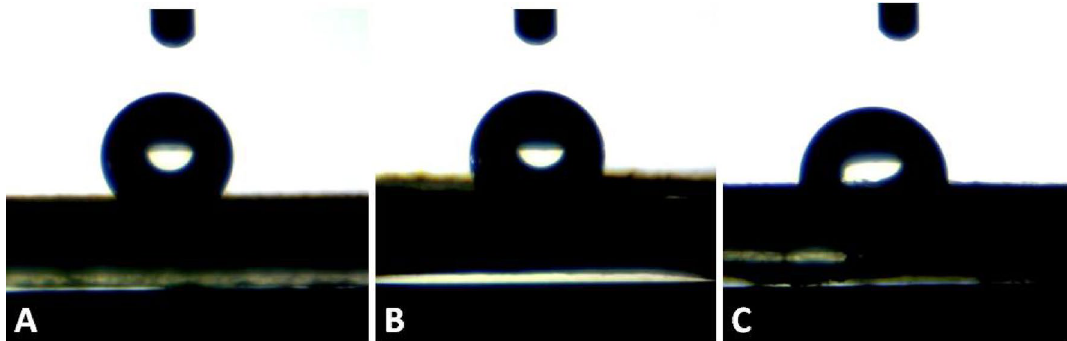
Figure 2. The surface contact angle of different PCL solutions in the 20th second ( P -value < 0.0005). ( A ) PCL 5% ( B ) PCL 7.5% ( C ) PCL 10%.